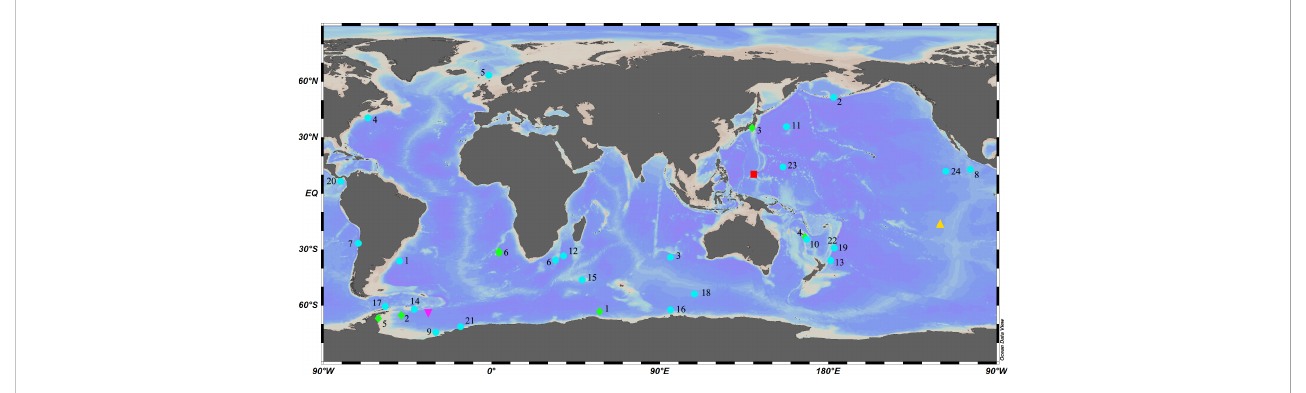
FIGURE 1 Global diversity of Caulophacus : Caulophacus (Caulophacella) tenuis . Caulophacus (Oxydiscus) weddelli . Caulophacus (Caulodiscus): 1, C. valdiviae ; 2, C. brandti ; 3, C. lotifolium; 4, C. onychohexactinus; 5, C. leonieae; 6, C. polyspiculus . Caulophacus (Caulophacus): 1, C. abyssalis; 2, C. adakensis; 3, C. antarcticus; 4, C. agassizi; 5, C. arcticus; 6, C. basispinosus; 7, C. chilense; 8, C. cyanae; 9, C. discohexactinus; 10, C. discohexaster; 11, C. elegans; 12, C. galatheae; 13, C. hadalis; 14, C. instabilis; 15, C. latus; 16, C. oviformis; 17, C. palmeri; 18, C. pipetta; 19, C. ramosus; 20, C. schulzei; 21, C. scotiae; 22, C. serpens ; 23, C. variens; 24, C. wilsoni . Caulophacus (Caulodiscus) iocasicus sp.